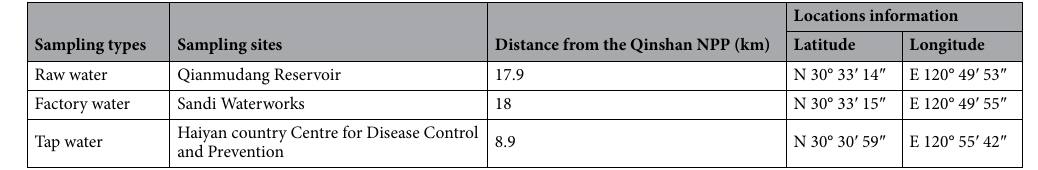
Table 1. Location information of sampling sites.